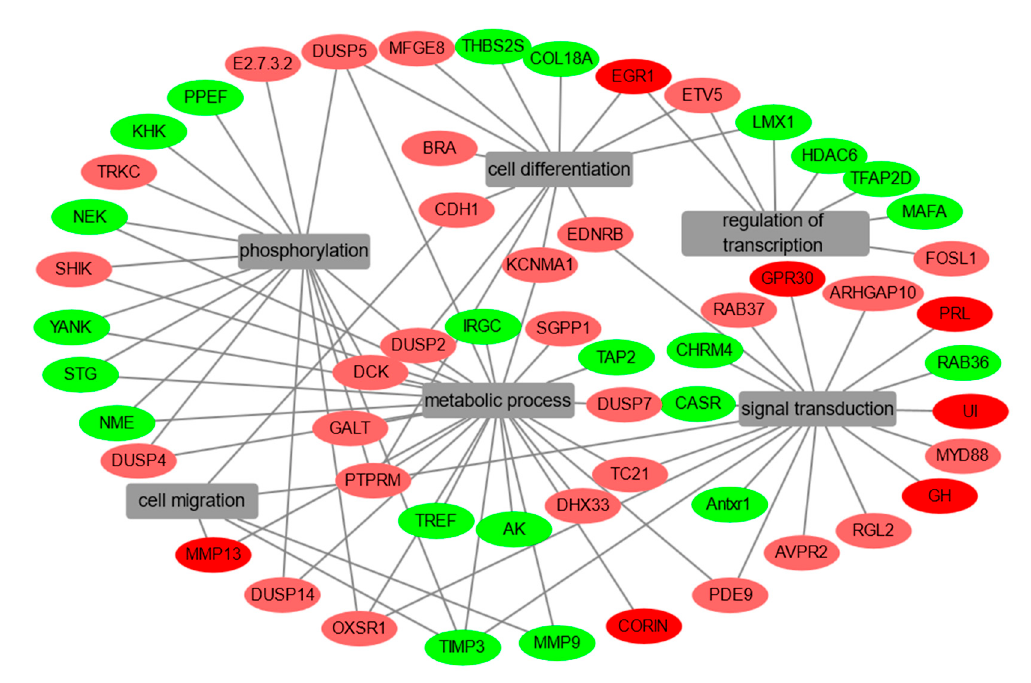
Figure 2. DEGs were enriched in the biological process of cell migration, cell differentiation, signal transduction, metabolic process, phosphorylation, and regulation of transcription in grass carp pituitary cells cultured by EGF treatment. Red indicates that the gene is increased, green indicates the gene is decreased in abundance relative to the control group and grey in the caption indicates the categories of biological process.